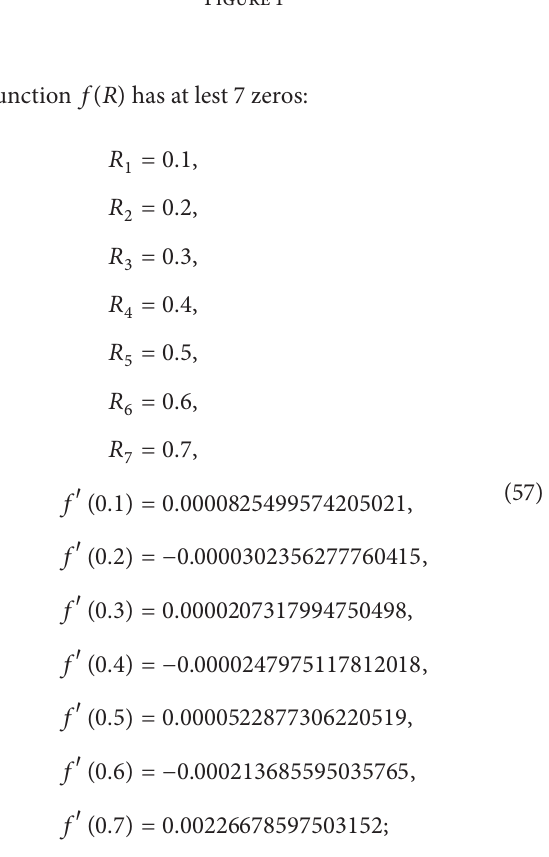
The function 𝑓(𝑅) has at lest 7